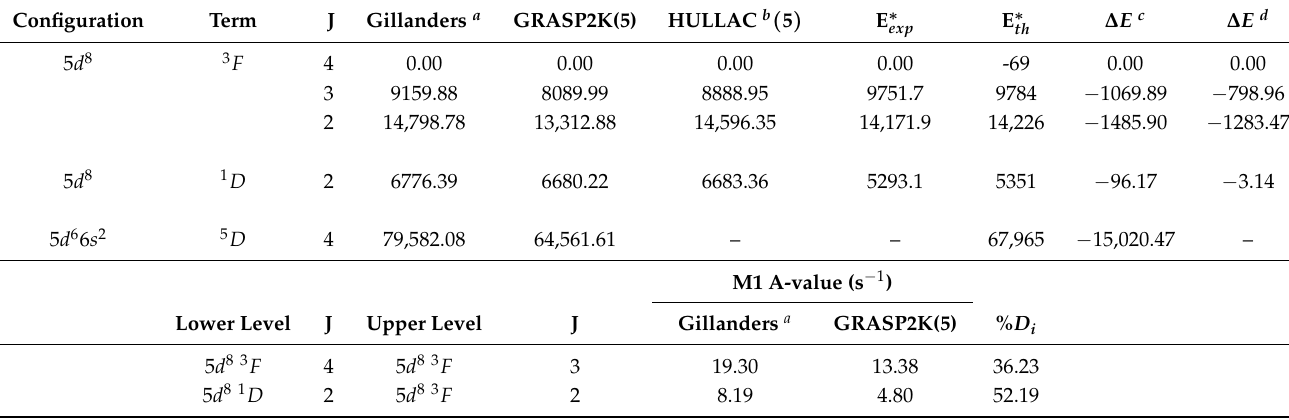
Table 5. Energy levels in cm − 1 and M1 transition for Pt III. The GRASP2K and HULLAC calculations have been performed with configuration numbers given in parentheses.